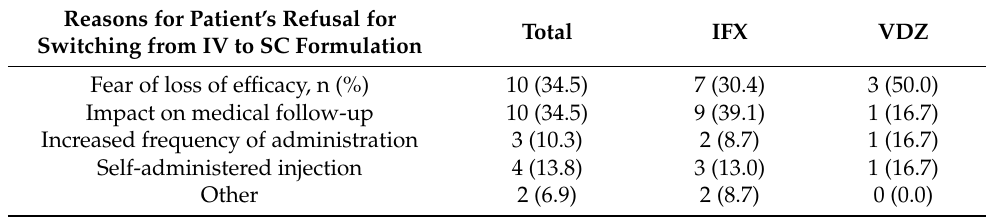
Table 3. Reasons for patient’s refusal for switching from IV to SC